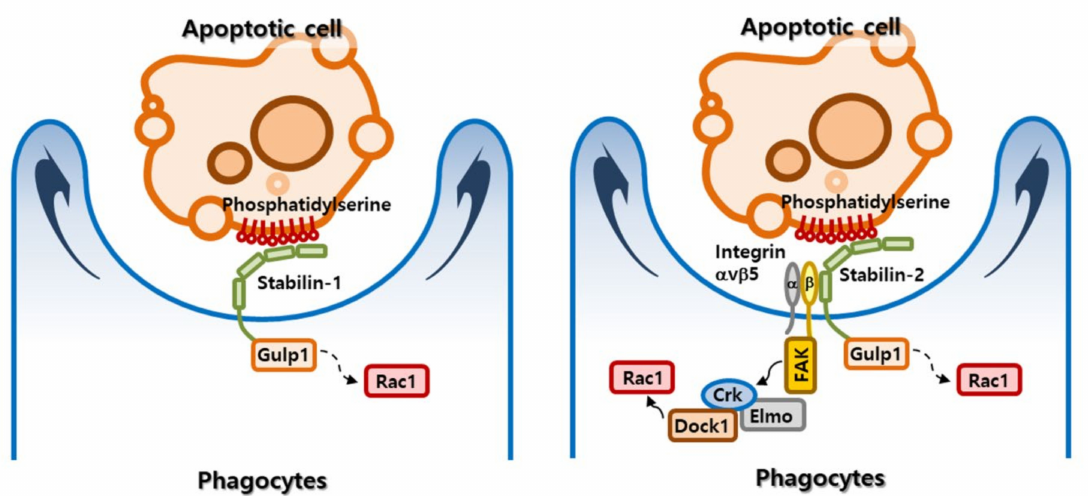
Figure 3. Signaling pathways elicited by stabilin-mediated phagocytosis of apoptotic cells. Stabilin-1 and stabilin-2 directly binds to phosphatidylserine on the surface of apoptotic cells, resulting in activation of Rac1 (Rac family small GTPase 1), which reorganizes the actin cytoskeleton for apoptotic cell engulfment via a Gulp1-dependent mechanism. However, intermediate signaling molecules between Gulp1 (phosphotyrosine-binding domain-containing engulfment adaptor protein 1) and Rac1 remain to be characterized. In the Gulp1-independent pathway, stabilin-2 interacts through its fasciclin I (FAS1) domains with integrin β 5, which in turn activates focal adhesion kinase (FAK) and recruits the CrkII (CRK adaptor protein)-ELMO1 (engulfment and cell motility 1)-DOCK1 (dedicator of cytokinesis 1; also referred to as DOCK180) complex, leading to activation of Rac1 and induction of cytoskeletal